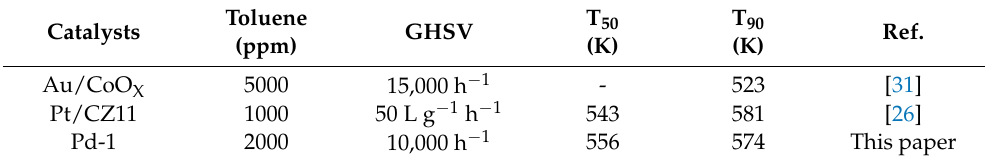
Table 6. Comparison of catalytic activity of supported noble metal catalysts for ethane